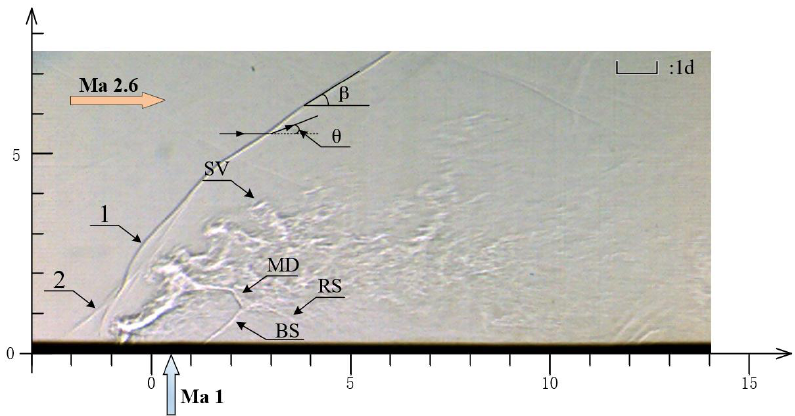
Figure 7. Transient flow field structure of Test 06.